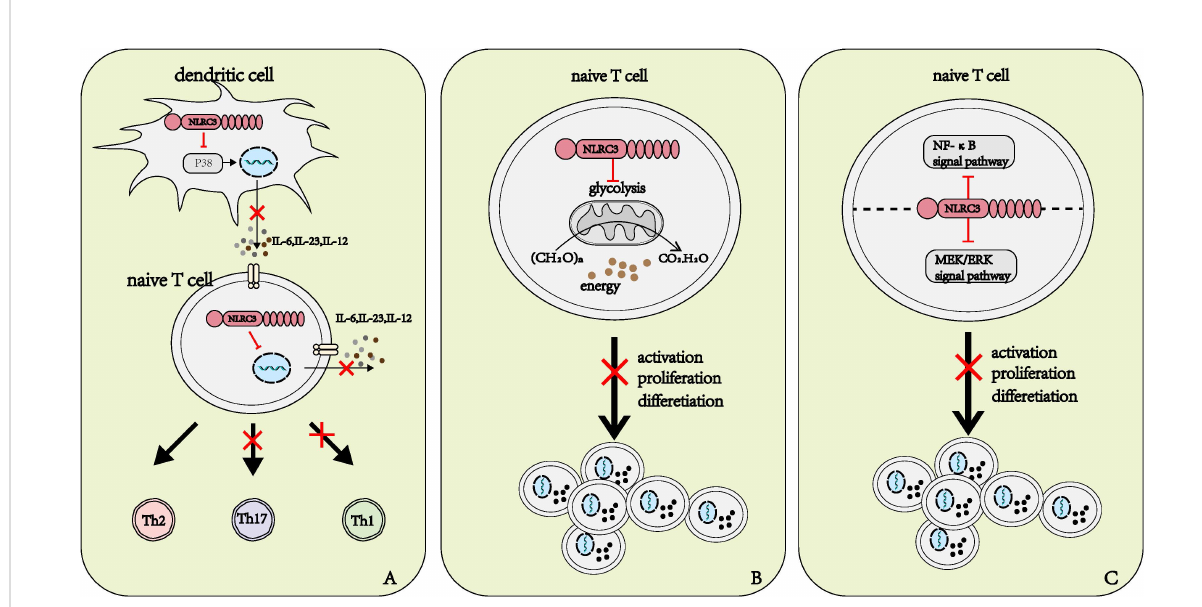
FIGURE 5 Roles of NLRC3 on T cells. (A) NLRC3 affects the differentiation direction of naïve T cells. NLRC3 prevents the production and release of IL-6, IL-23 and IL-12 in dendritic cells and naïve T cells, in DCs, NLRC3 executes regulatory roles by affecting P38 signal pathway. IL-12 promotes the differentiation of naïve T cells into Th1 cell, and IL-23, IL-6 promote the differentiation of naïve T cells into Th17 cell. (B, C) The potential several manners of NLRC3 affects the activation, proliferation and differentiation of T cells. (B) Suf fi cient energy is critical for the activation, proliferation and activation of naïve T cells, NLRC3 regulates the activation, proliferation and differentiation through negatively regulating mitochondrial function and the production of energy in naïve T cells (C) NLRC3 inhibits the activation of both NF- k B and MEK/ERK signal pathways and further inhibit the activation, proliferation and differentiation of T